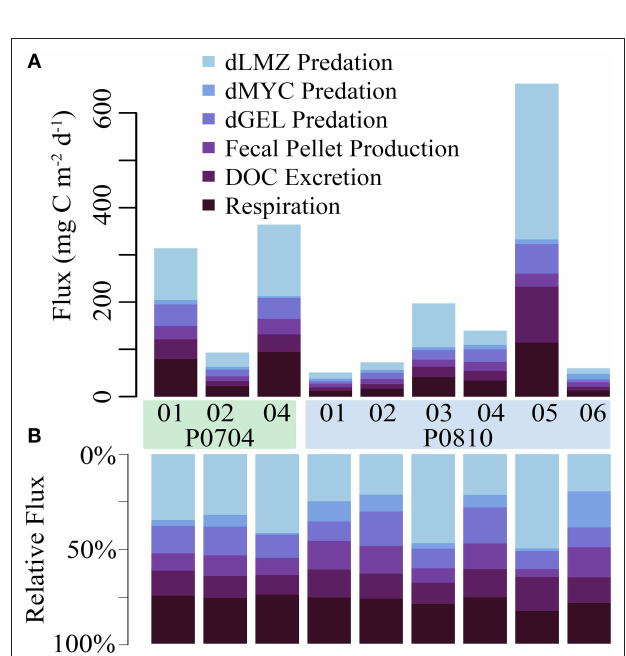
FIGURE 7 | The (A) net and (B) relative fate of vertically migrating mesozooplankton within the mesopelagic. Loss terms are color coded, and cruise and cycle are as shown. Abbreviations are explained in Table 2